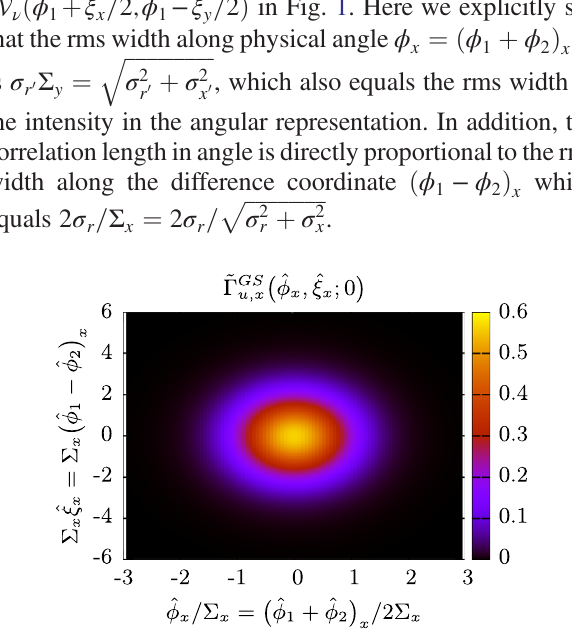
FIG. 1. Gaussian-Schell model cross-correlation function ~ Γ W ϕ ξ = 2 ; ϕ 1 − ξ = 2 Þ given by (35). The rms width ν ;y ¼ ν ð 1 þ x x ˆ ϕ in the average coordinate is of order the total divergence Σ ϕ x while the correlation length along the difference coordinate ˆ ξ is ∼ 1 = Σ x x